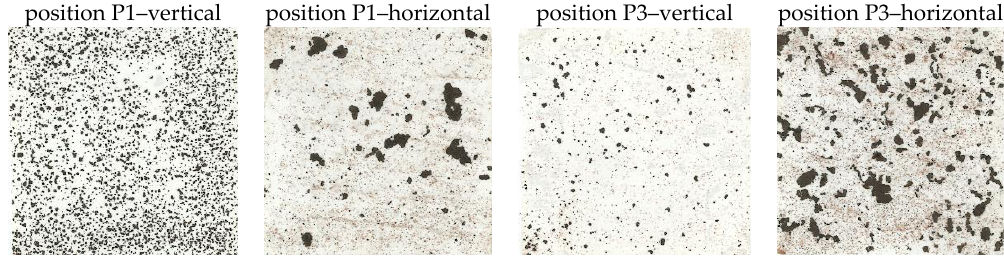
Figure 7. Scotch-tape test for positions P1 and P3 for vertical and horizontal placement of the surface of the steel coupon and one-year exposure.